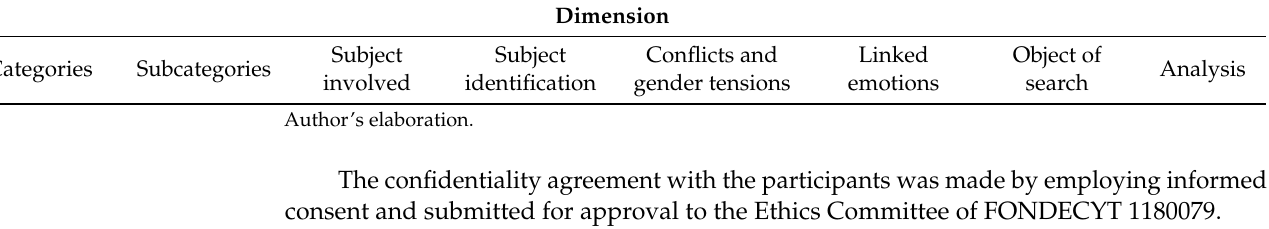
Table 1. Example of a discourse analysis and ordering matrix.